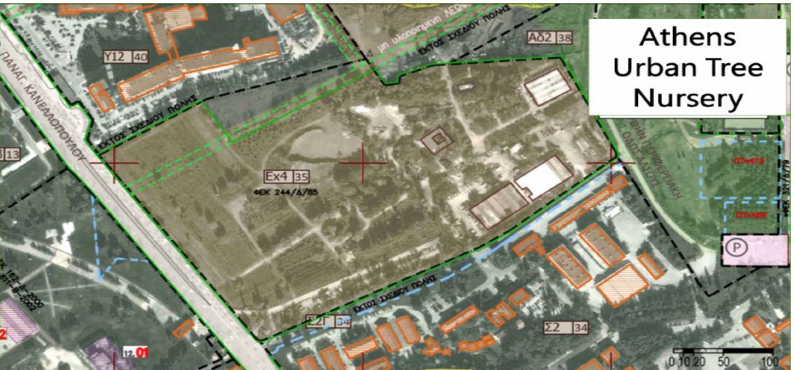
Figure 1. Area of the Athens Plant Nursery.